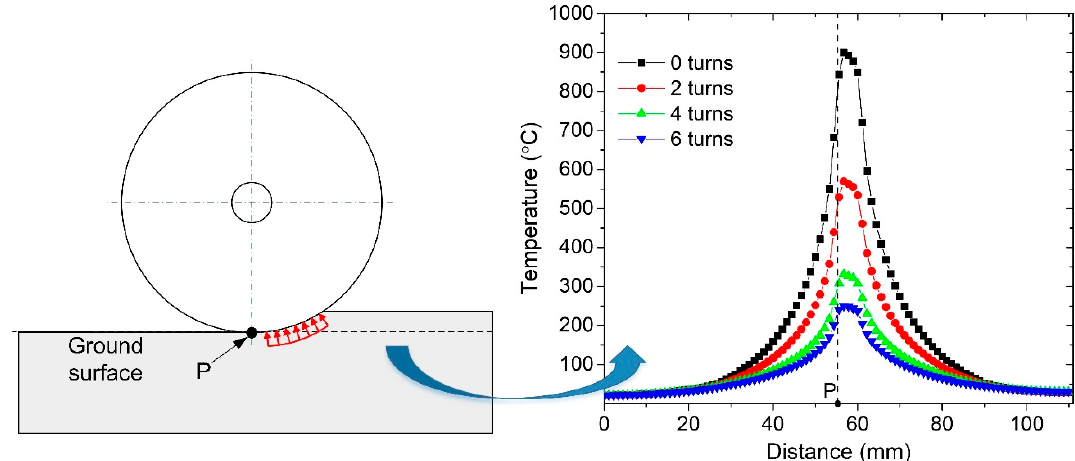
Figure 13. Temperature distribution on the ground surface under a grinding heat flux of 10 7 W / m 2 .